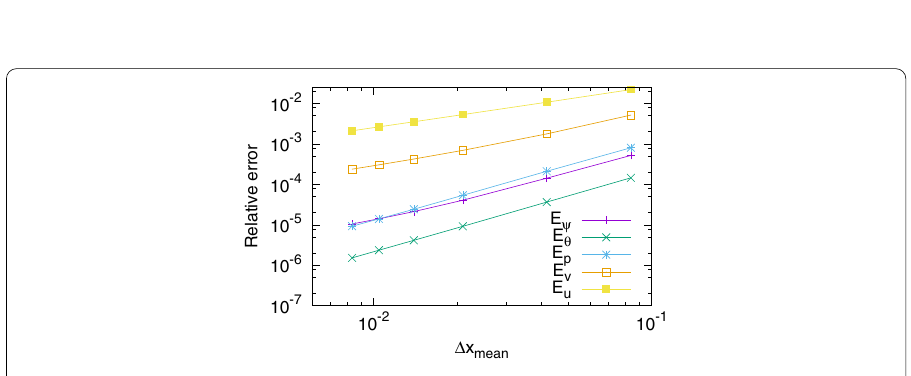
Fig. 33 Poiseuille flow: Relative error on vorticity ψ , temperature θ , flux v , dynamical pressure and velocity u